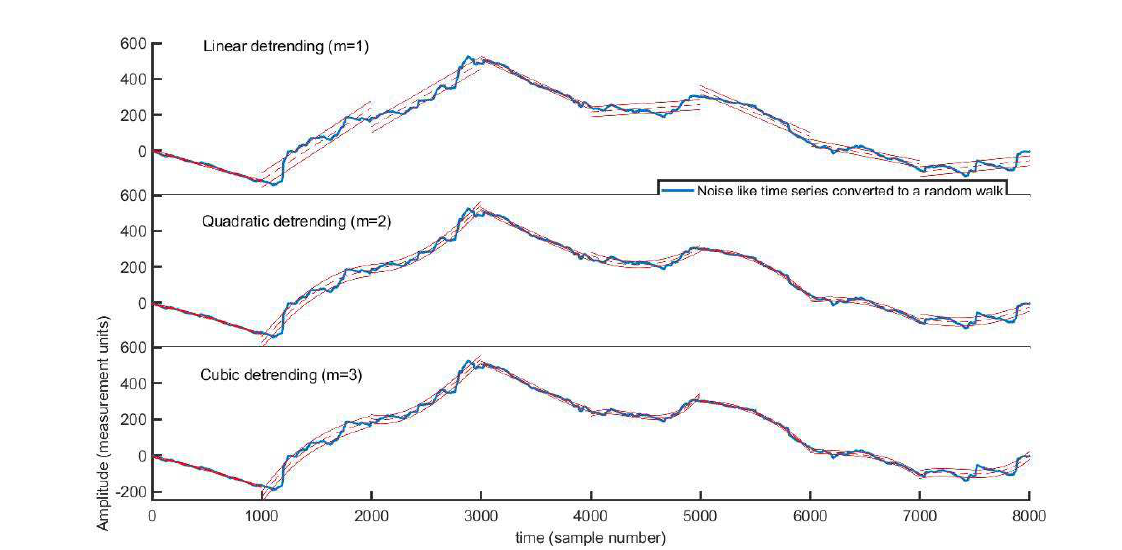
Figure 2. Cubic, quadratic, and linear detrending